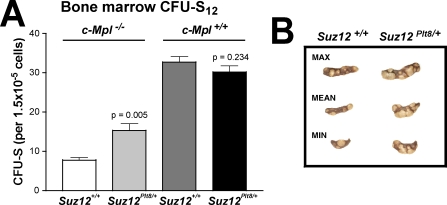
The Plt8 Mutation Enhances CFU-S Frequency in c-Mpl–/– Mice(A) CFU-S frequency was assessed in bone marrow derived from Suz12Plt8/+ mice and wild-type littermates. Irradiated recipients received 1.5 × 105 nucleated bone marrow cells from c-Mpl–/– donors or 7.5 × 104 cells from c-Mpl+/+ donors. Data represent the mean of 4–6 mice of each genotype, and error bars show the standard error of the mean. Statistical significance was assessed using an unpaired t-test.(B) Representative spleens from recipients of Suz12Plt8/+ c-Mpl–/– and Suz12+/+ c-Mpl–/– bone marrow were photographed to detail the size and number of colonies (at right).